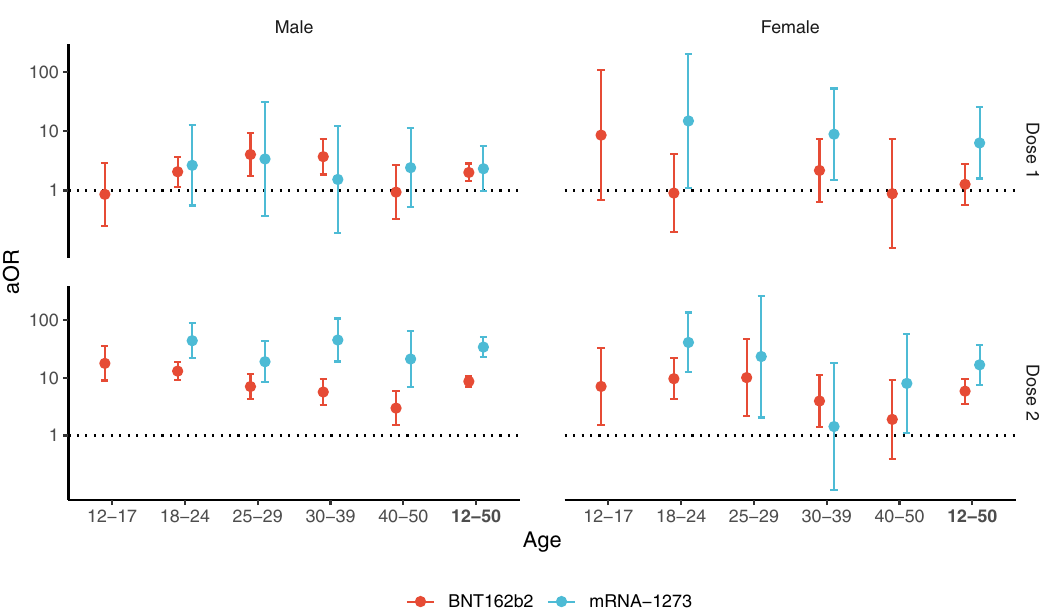
Fig. 1 Association between myocarditis and exposure to mRNA vaccines within 7 days, according to sex and age group. Adjusted odds-ratio (aOR) from multivariable model are represented in base 10 logarithmic scale according to age groups ( x -axis), by sex (columns) and vaccine dose ranking (rows). Colors denote the type of vaccine. Centre value are aOR point estimates and error bars represent 95% con fi dence intervals. Number of cases (N) by age categories (12 – 17, 18 – 24, 25 – 29, 30 – 39, 40 – 50 and 12 – 50 years) are respectively as follows: N = 137, 480, 210, 273, 181 and 1281 for males, and N = 29, 106, 40, 88, 68 and 331 for females. aOR could not be calculated in categories where no case exposed to vaccine was recorded, for instance for males and females aged 12 to 17 years having received the mRNA-1273 vaccine.